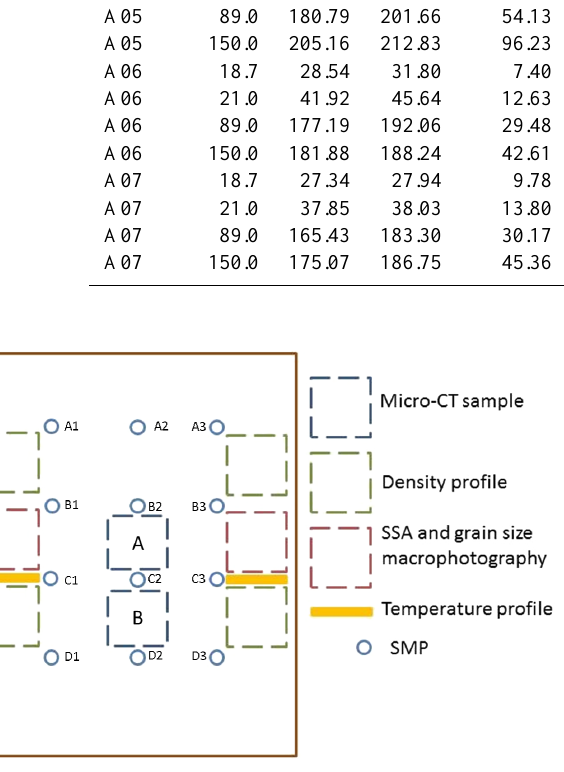
Figure 3. Approximate locations of the macro- and microstructure measurements in the snow slab. Individual SMP and micro-CT mea- surement locations are also